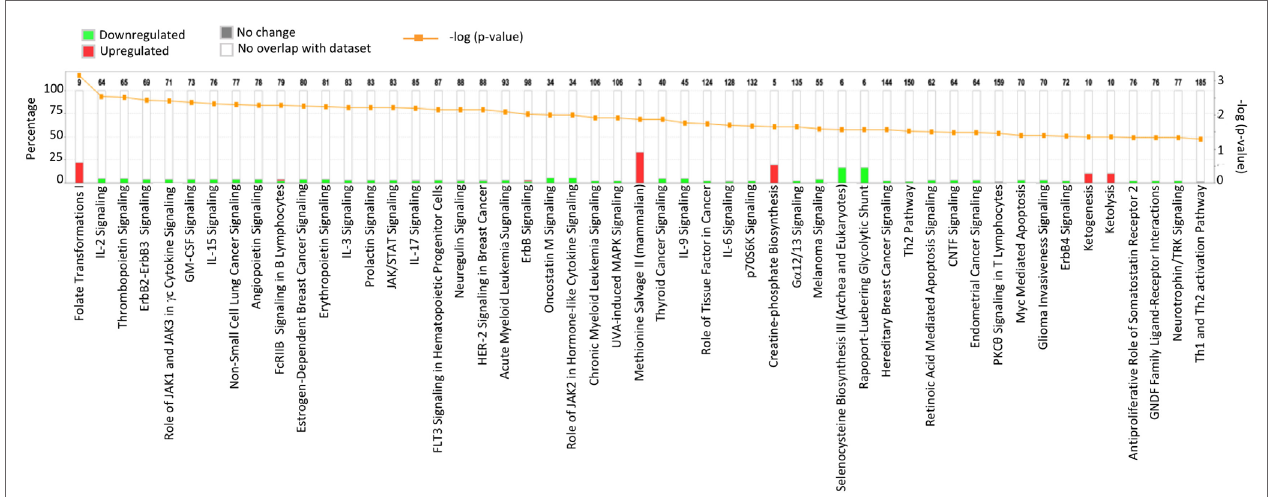
FigUre 9 | Ingenuity Pathway Analysis of the 246 transcript cluster IDs (TCIDs) significantly altered in Tgfbr2 Δ DC testis. Identified pathways with overrepresented TCIDs are depicted on the X -axis. Left Y -axis denotes the percentage of genes among the 246 TCIDs in the total number of genes in any given category (total number of genes in each pathway is directly above each stacked bar). Right Y -axis (yellow line) depicts negative logarithm of the p -value for each pathway. The number of upregulated genes in Cre + mice is depicted in red, while downregulated genes are shown in